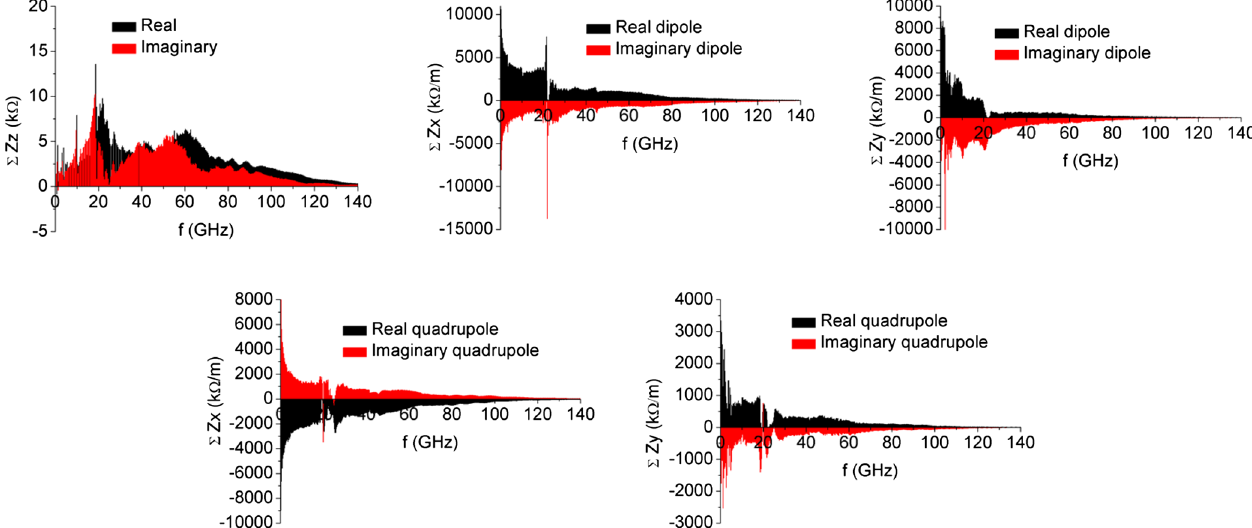
FIG. 1. APS impedance; longitudinal impedance ( z ), transverse ( x and y ) dipole impedance, and transverse ( x and y ) quadrupole